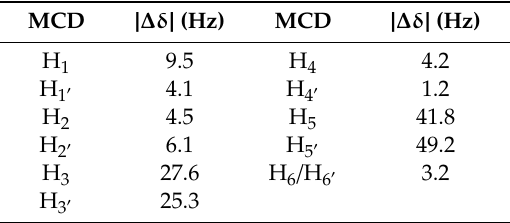
Table 4. MCD (600 MHz, D 2 O, 25 °C, 9.8 mM) complexation shifts.